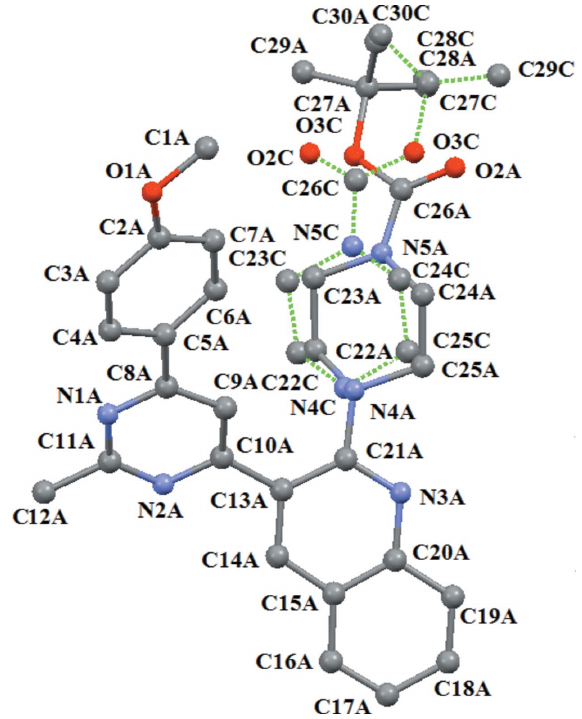
Figure 1 The molecular structure of molecule A showing 30% probability displacement ellipsoids. The minor disorder component is shown with green dashed bonds. H atoms are omitted for